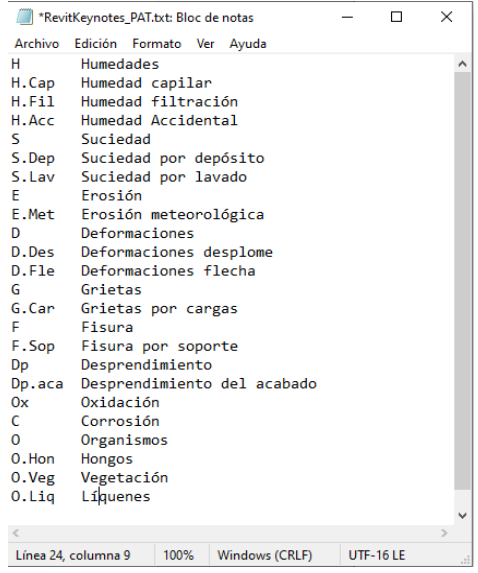
Figure 20. Screenshot of injury legend entered in Revit as keynotes.